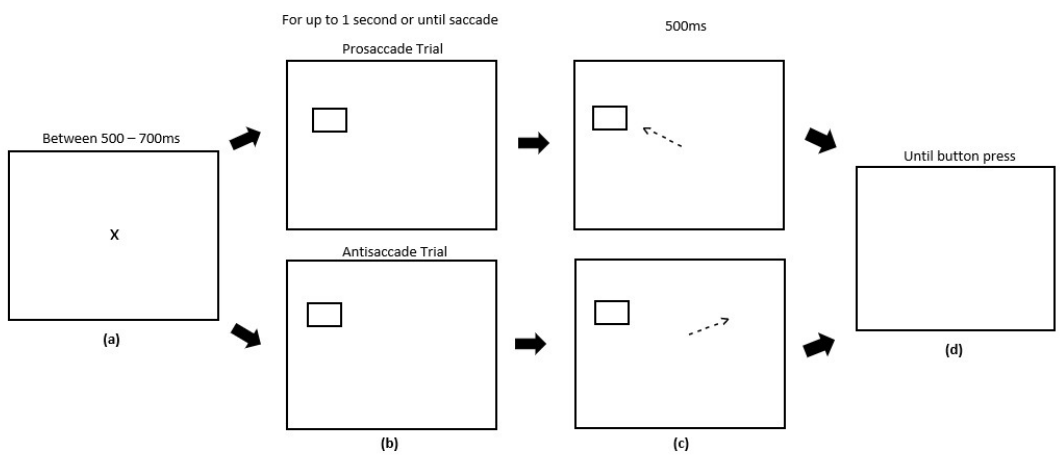
Figure 5. Sequence of events used in the antisaccade task (not to scale). ( a ) Participants were presented with a fixation cross for a variable time limit between 500–700 ms. ( b ) Participants were presented with a target square to either the left or right hemifield which displayed for 1000 ms or until a saccade was made (Panels 1 and 2). ( c ) On prosaccade trials, participants were required to saccade towards the target (Panel 1). On antisaccade trials, participants were required to saccade away from the target (Panel 2). After making a saccade, the target would embolden and be displayed for 500 ms. ( d ) Participants were presented with a blank screen after 500 ms. A button press was required to begin the next